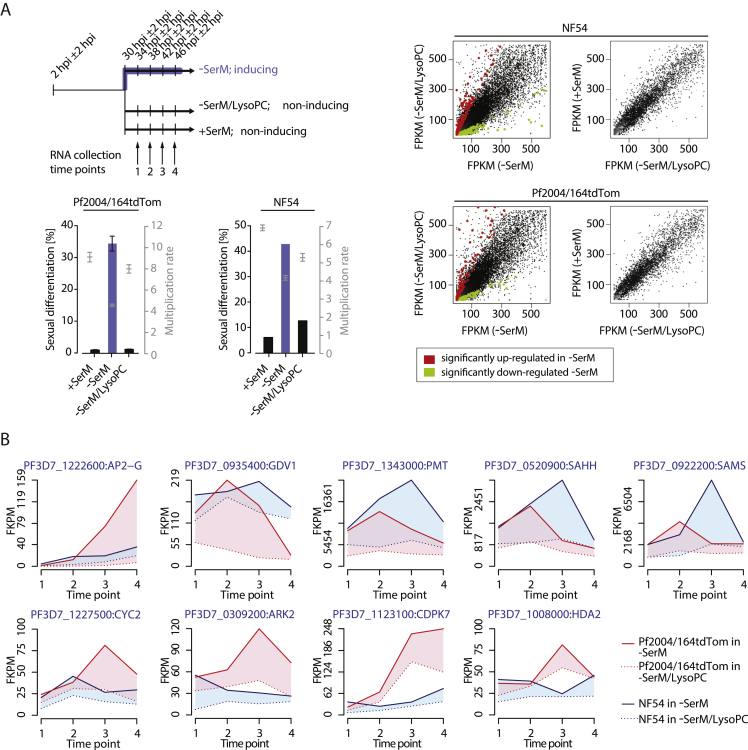
Related to Figure 4(A) Schematic depiction of parasite culturing setup used for transcriptional analysis (upper left panel). Pf2004/164tdTom and NF54 parasite cultures were split at 30±2 hpi and parasites were subsequently grown under conditions that either induce (−SerM) or do not induce (−SerM/LysoPC; +SerM) sexual differentiation. Time points of RNA harvest are indicated. Effect of culture conditions on parasite sexual differentiation and multiplication is shown (lower left panels, standard deviations are indicated). Global effect of culture conditions on differential gene expression (Pf2004/164tdTom and NF54, combined) is shown in scatterplots on the right. FPKM, fragments per kilobase of exon per million mapped reads.(B) Effect of LysoPC on gene expression of selected genes. Normalized read counts are given for different conditions (−SerM and −SerM/LysoPC) and time points. Differential gene expression is indicated by shaded areas (red, Pf2004/164tdTom; blue, NF54). FPKM, fragments per kilobase of exon per million mapped reads.